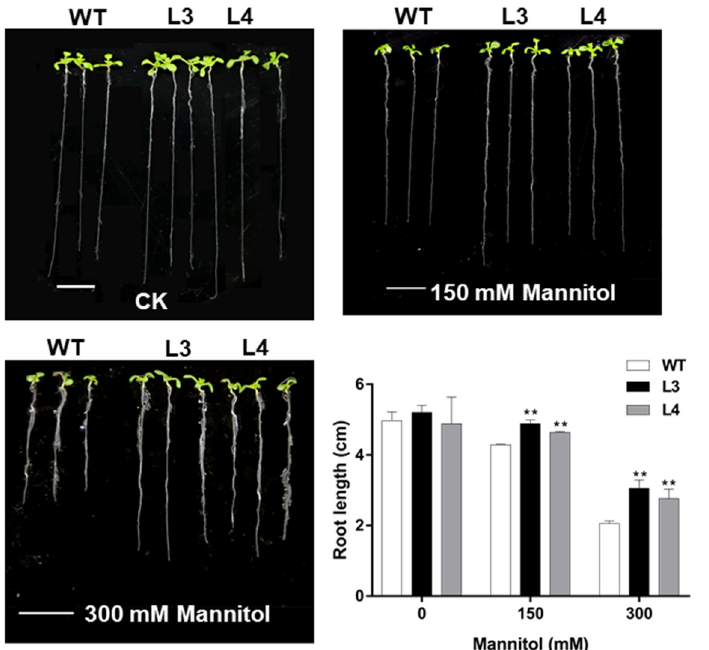
Figure 5. Root elongation analysis of Arabidopsis under mannitol treatment. Error bars represent ± SD ( n = 3). Asterisks denote significant differences (as compared with the control group): ** p < 0.01.